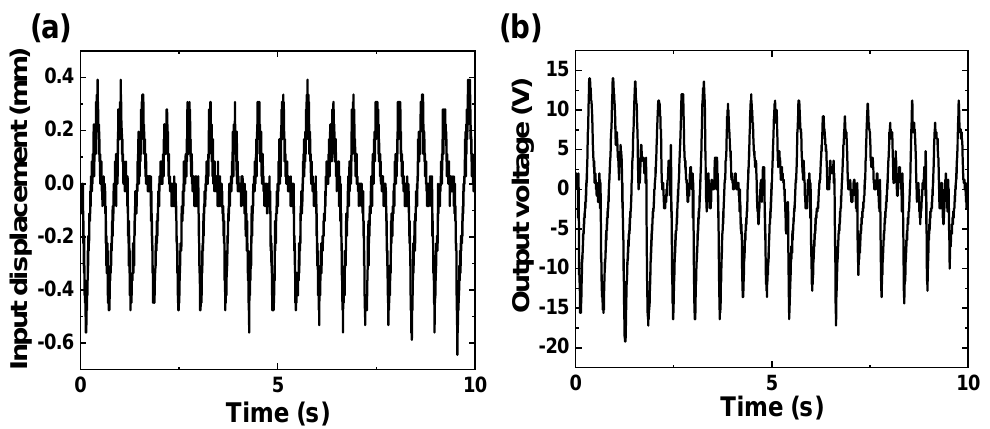
Figure 8. The curves of measured ( a ) input displacement and ( b ) corresponding output voltage.